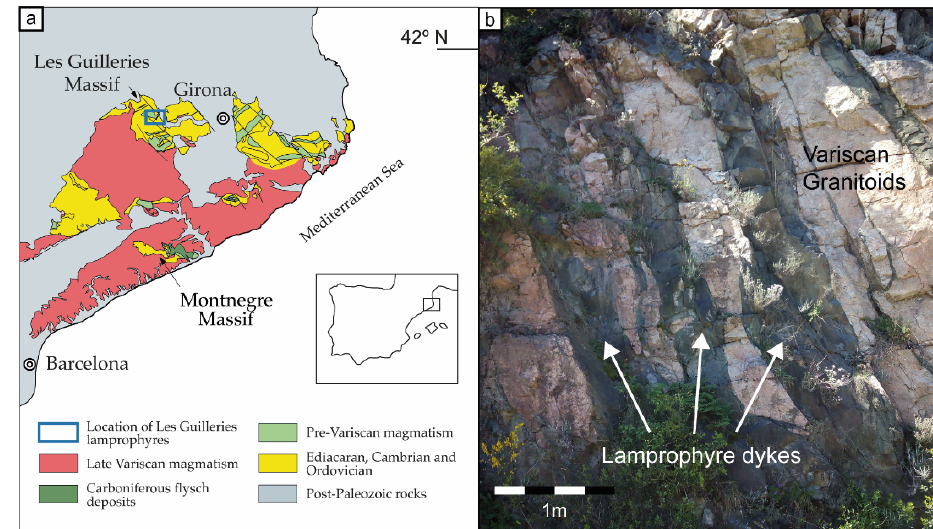
Figure 1. ( a ) Simplified geological map of the northernmost Catalan Coastal Range and geographic location of Les Guilleries massif; ( b ) Photograph of Les Guilleries spessartites dykes.